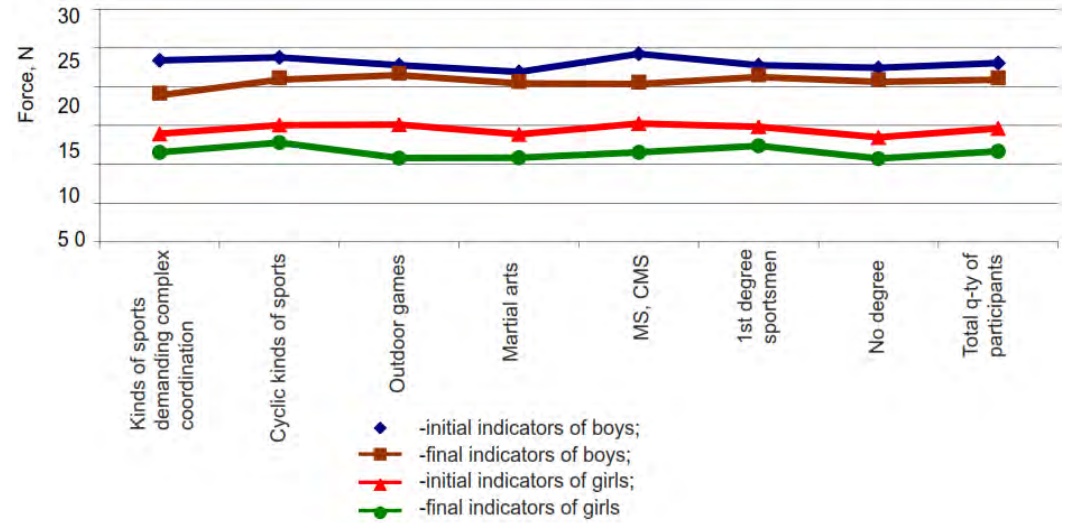
Fig. 14. Indicators, which characterize coordination abilities to evaluation of proprioceptor sensitiveness, under changed hemo dynamics of first year students of NU PESU